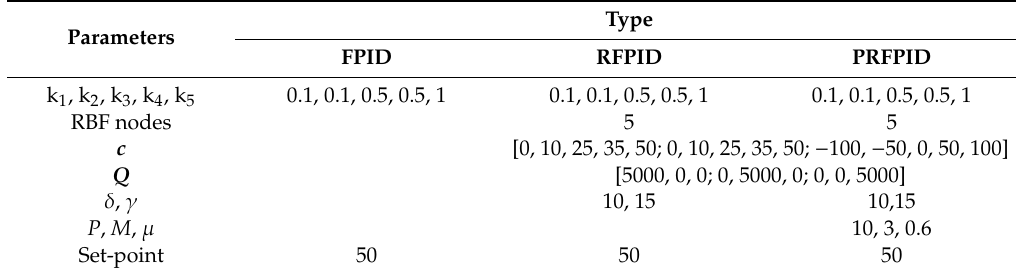
Table 7. Controller parameters of step response.